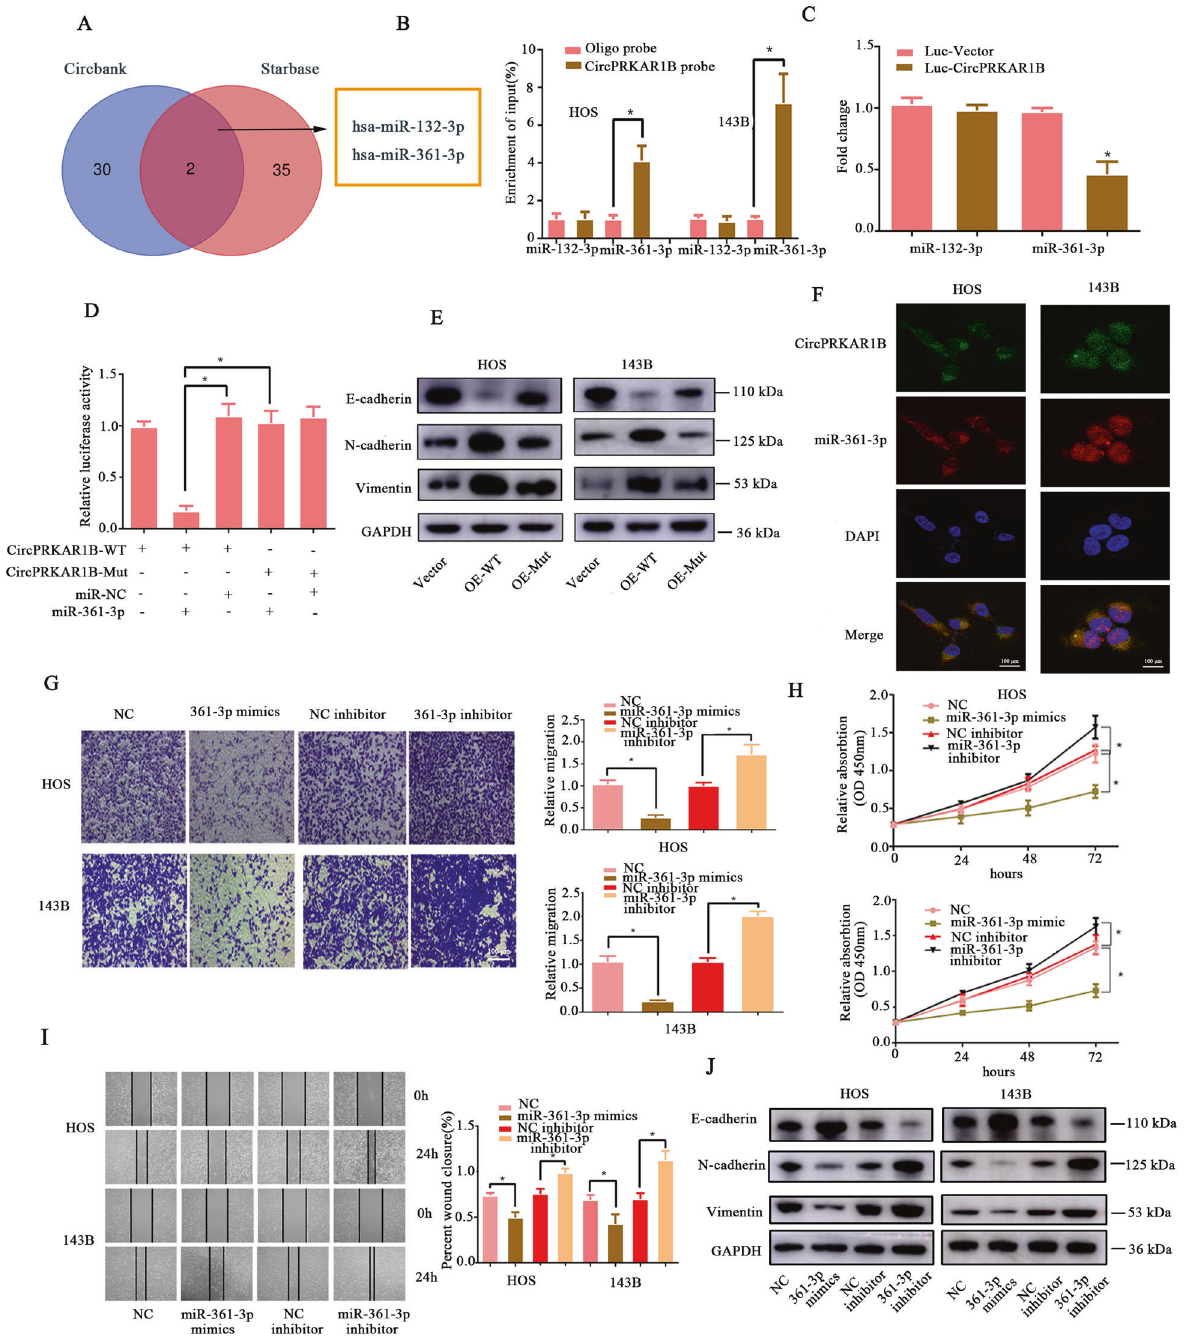
Fig. 3 CircPRKAR1B acts as a sponge for miR-203a-3p, which suppresses OS cell proliferation, migration, and EMT. A Schematic illustration exhibiting the overlapping of the target miRNAs of circTADA2A predicted by circBank and starBase. B Lysates prepared from HOS and 143B cells stably transfected with circPRKAR1B or vector were subjected to RNA pull-down assays and were analysed by RT-qPCR. The relative levels of circPRKAR1B pulled down by the circPRKAR1B probe were normalised to the level of circPRKAR1B pulled down by an oligo probe. C Relative luciferase activity of the circPRKAR1B luciferase reporter after cotransfection of different candidate miRNA mimics into HEK-293T cells. D HEK-293T cells were co-transfected with miR-361-3p mimics or NC and the wild-type or mutant circPRKAR1B luciferase reporter and subjected to the luciferase assay. E Western blot analyses of EMT-associated proteins after the overexpression of circPRKAR1B or its mutant. F FISH revealed colocalization between miR-361-3p and circPRKAR1B in HOS and 143B cells. CircPRKAR1B probes were labelled with Alexa Fluor 488. MiR-361-3p probes were labelled with Alexa Fluor 555. Nuclei were stained with DAPI; G HOS and 143B cells were transfected with miR-361-3p mimics or a miR-361-3p inhibitor, and cell migration was evaluated after 48 h. H Downregulation of miR-361-3p expression stimulated cell growth, and overexpression of miR-361-3p suppressed cell growth in HOS and 143B cells. I Migration ability of transfected PTC cells was evaluated by the wound-healing assay. J The protein expression of N-cadherin, E-cadherin, and Vimentin was measured by Western blot analysis in both HOS and 143B cells transfected with miR361-3p-mimics or a miR-361-3p inhibitor. The data represent the mean ± SD of three independent experiments (* P < 0.05).